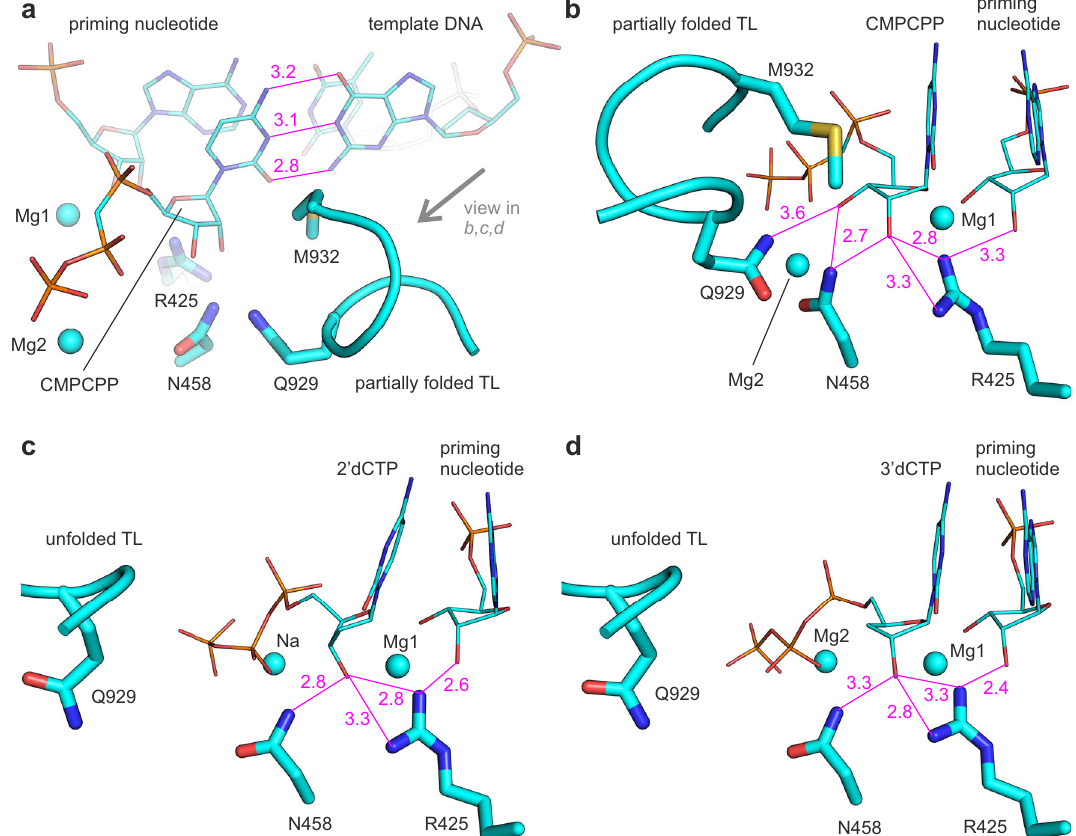
Fig. 7 X-ray crystal structures of T. thermophilus RNAP with ribo- and deoxyribonucloside substrates. Crystallographically observed binding poses of CMPCPP ( a , b ), 2 ′ dCTP ( c ), and 3 ′ dCTP ( d ) in the active site of T. thermophilus RNAP. Magenta numbers are interatomic distances in Å. Panels a and b were prepared using PDB ID 4Q4Z 18 . Pre-catalytic complexes in c and d were trapped due to the low reactivity of deoxyribonucleoside substrates and the slow catalysis by RNAP in crystallo 52 . Source data are provided as a Source Data fi